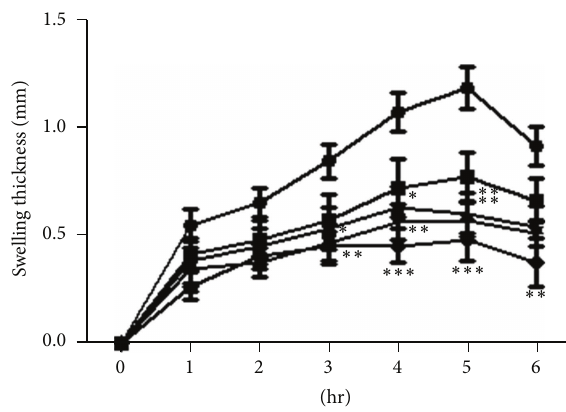
Figure 5: Inhibitory effect of patulitrin on histamine-induced hind- paw edema in mice. Drugs were administered p . o . 30min before histamine (5 𝜇 g). e : control; ◼ : patulitrin 5 mg/kg; 󳵳 : patulitrin 15mg/kg; 󳶃 : patulitrin 50 mg/kg; Q : cyproheptadine 10mg/kg. Significantly different from the control, ∗ 𝑃 < 0.05 or ∗∗ 𝑃 < 0.01 . Eachvaluerepresentsthemean ± SDof5.Significantlydifferentfrom the control, ∗ 𝑃 < 0.05 , ∗∗ 𝑃 < 0.01 , or ∗∗∗ 𝑃 < 0.001 . Each value represents the mean ± SD of 5